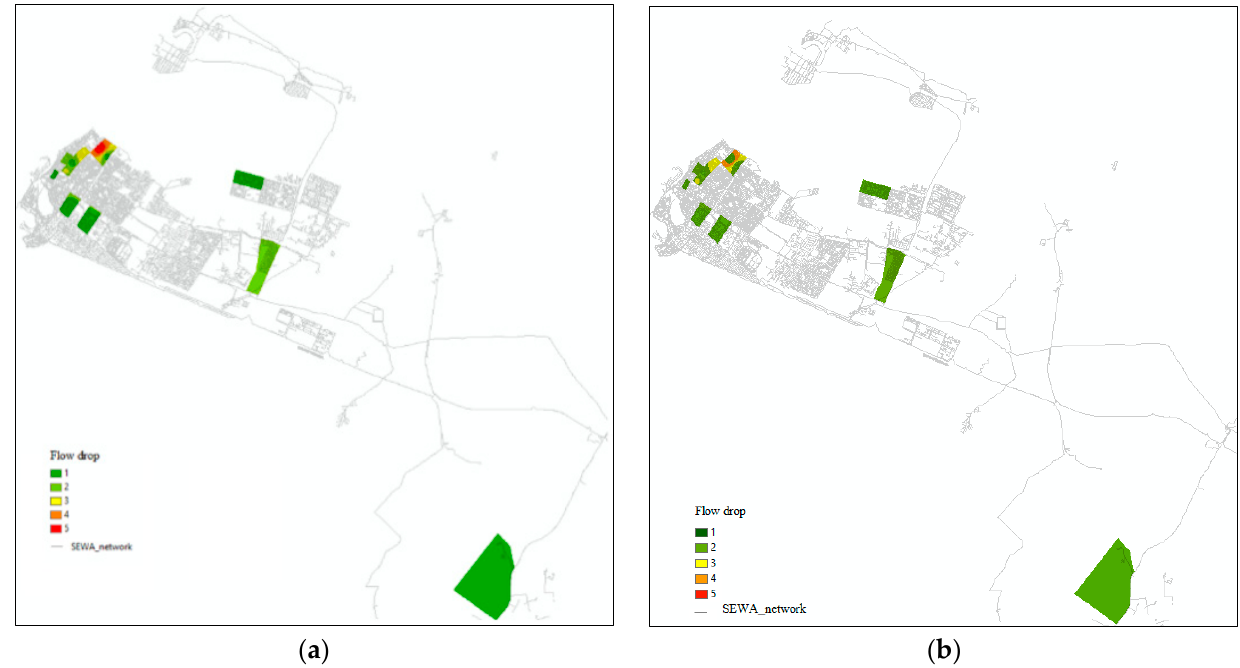
Figure 6. Flow drops maps. ( a ) Highest flow drop; ( b ) lowest flow drop.